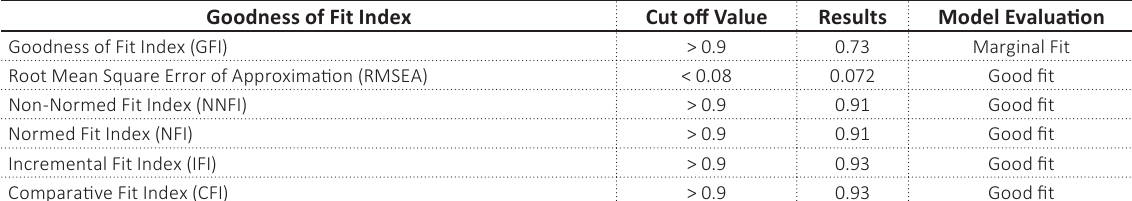
Table 2. Goodness of fit